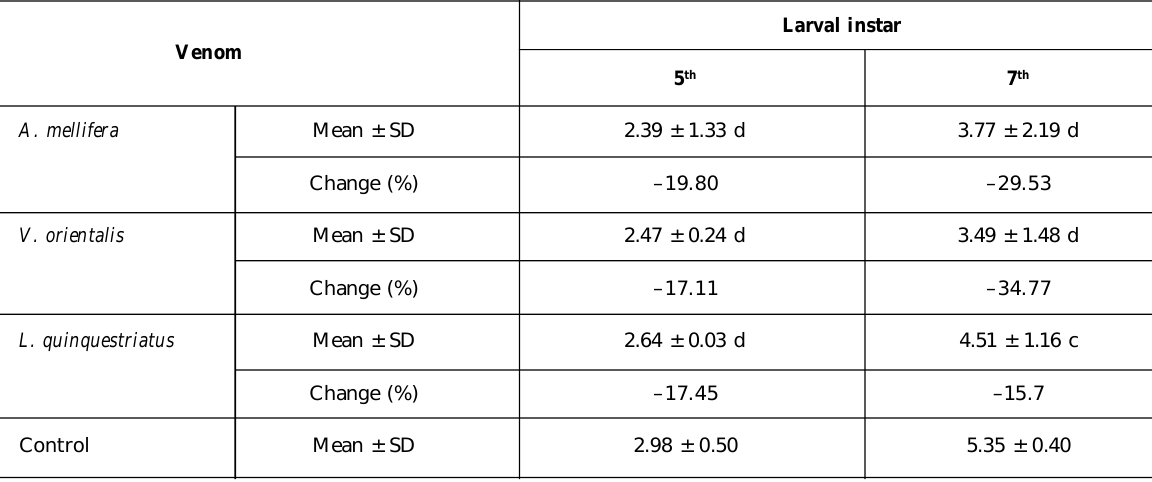
Table 1: Influenced total protein content (mg/g) in the larval tissues after treatment of the 3 rd instar larvae of G. mellonella with LC values of certain arthropod 50